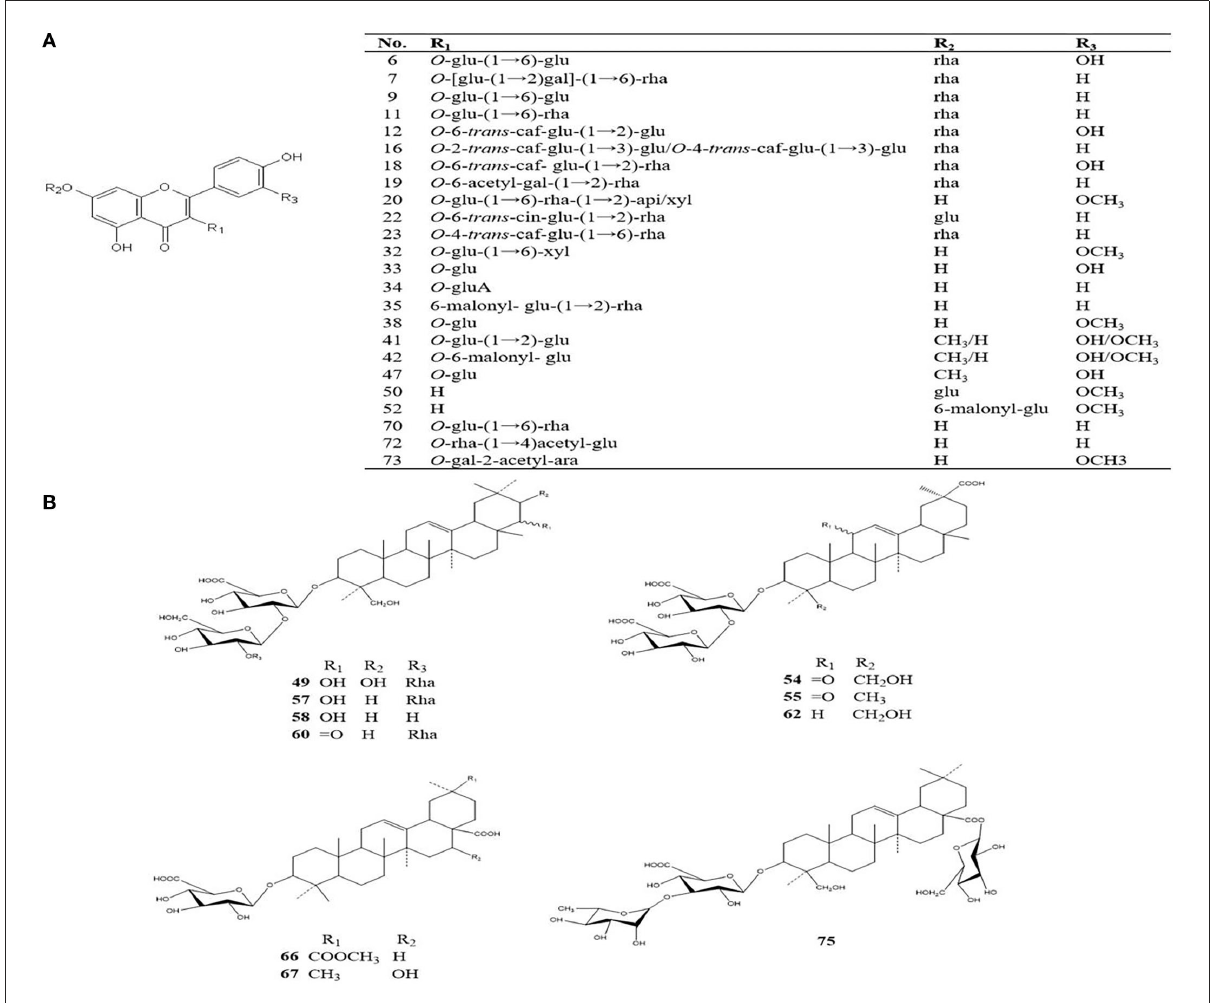
FIGURE2 Typical chemical structures of flavonoid glycosides and saponins identified from Oxytropis [ (A) flavonoids; (B)